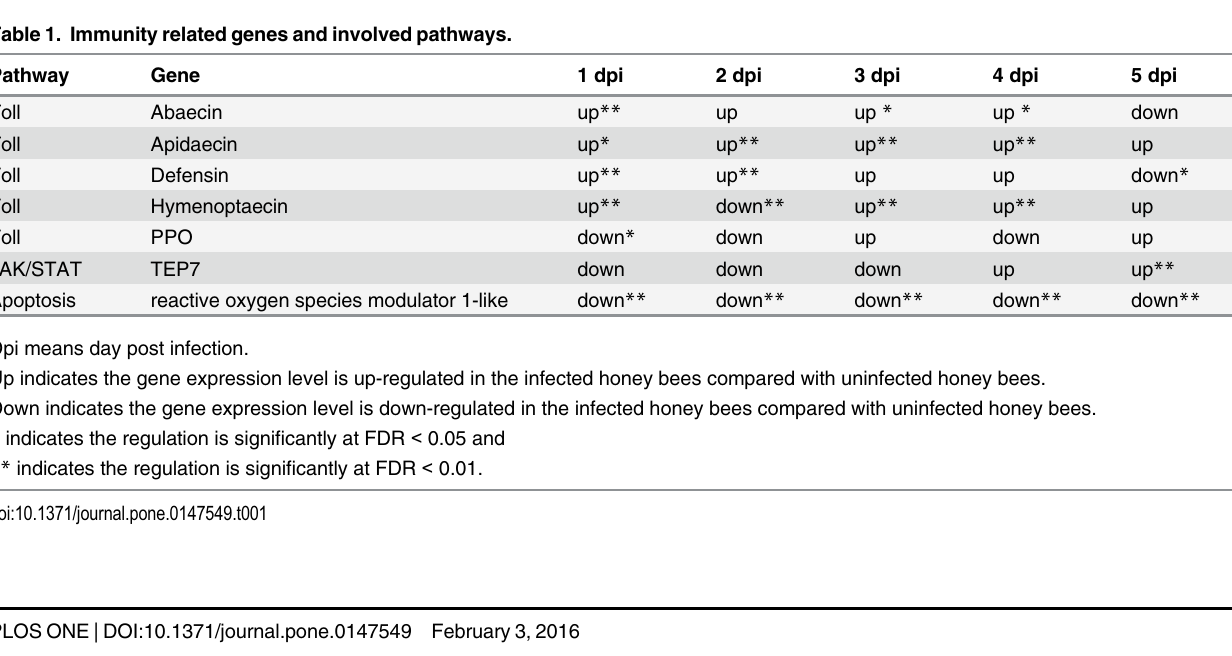
was only detected at 5 dpi (p < 0.01) (Table 1).